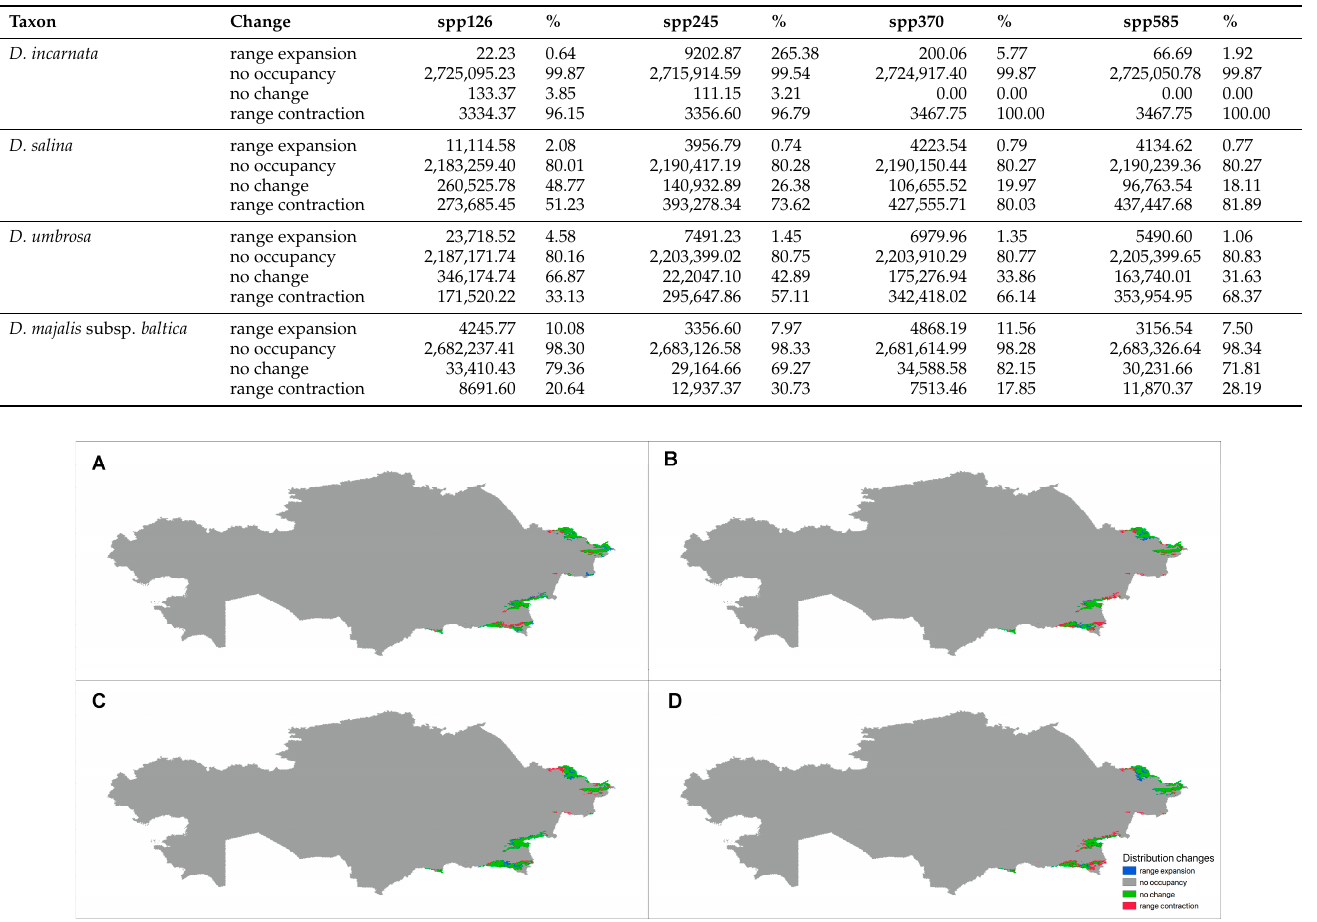
Table 4. Comparison of the results of potential changes in the area of occurrence (threshold 0.5) for the four future climate change scenarios versus the models for the present (in km 2 ) along with the percentage of this change. The percentage of change is expressed in relation to the area of occurrence for the present, and for the no occupancy in relation to the total area of the country.